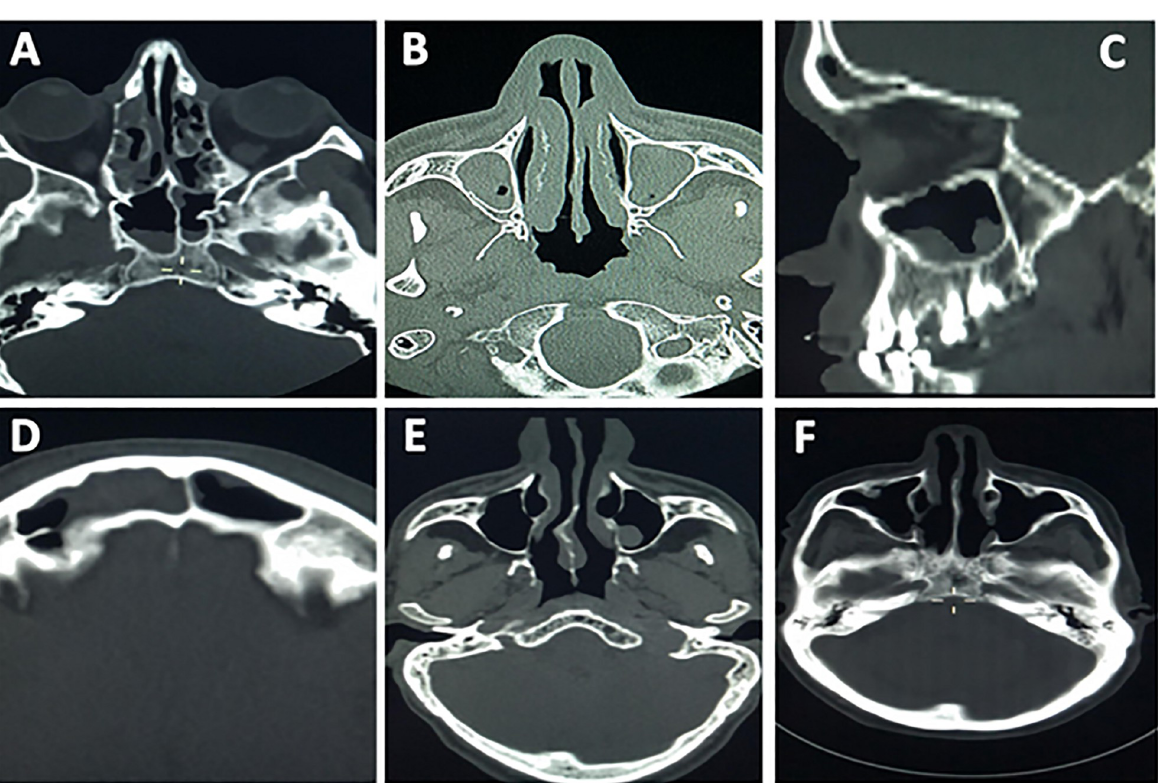
Fig 3. Patients brain CT scans show the incidental detection of paranasal sinuses abnormalities; (A) right maxillary antrum polyp, (B) bilateral maxillary polyp with retention cyst, (C) maxillary antrum polyp and right nasal air fluid level likely abscess, (D) right frontal sinusitis, (E) normal paranasal study, (F) right maxillary antrum mucosal thickening.